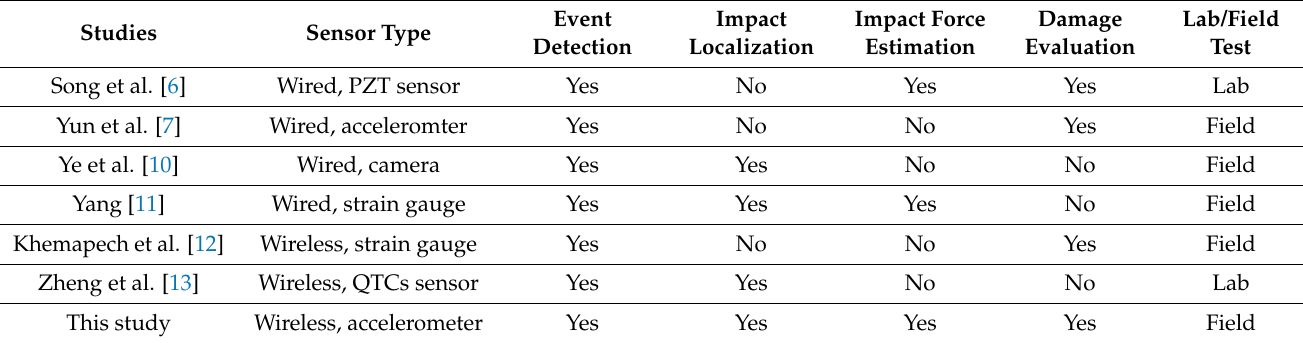
Table 5. Comparison of bridge impact monitoring